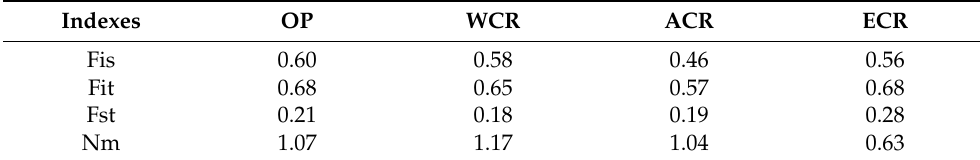
Table 2. Population differentiation within the overall radish population and cultivated radish